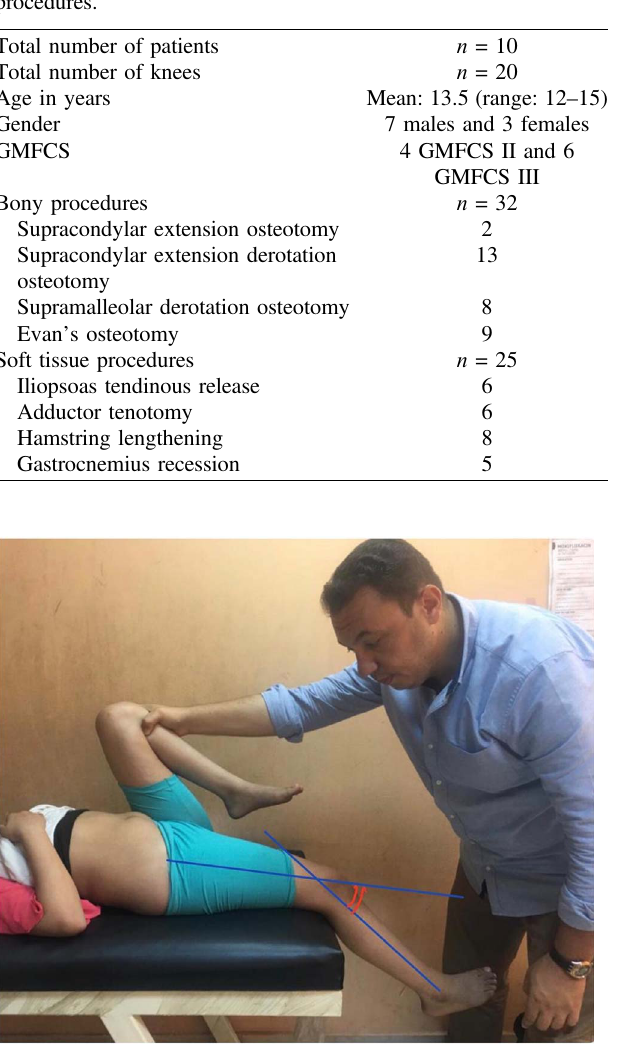
Figure 1. Measurement of the knee extensor lag depicted by the angle at the intersection of both blue lines with ipsilateral hip extension and fl exion of the contralateral hip to minimize the stretch of the